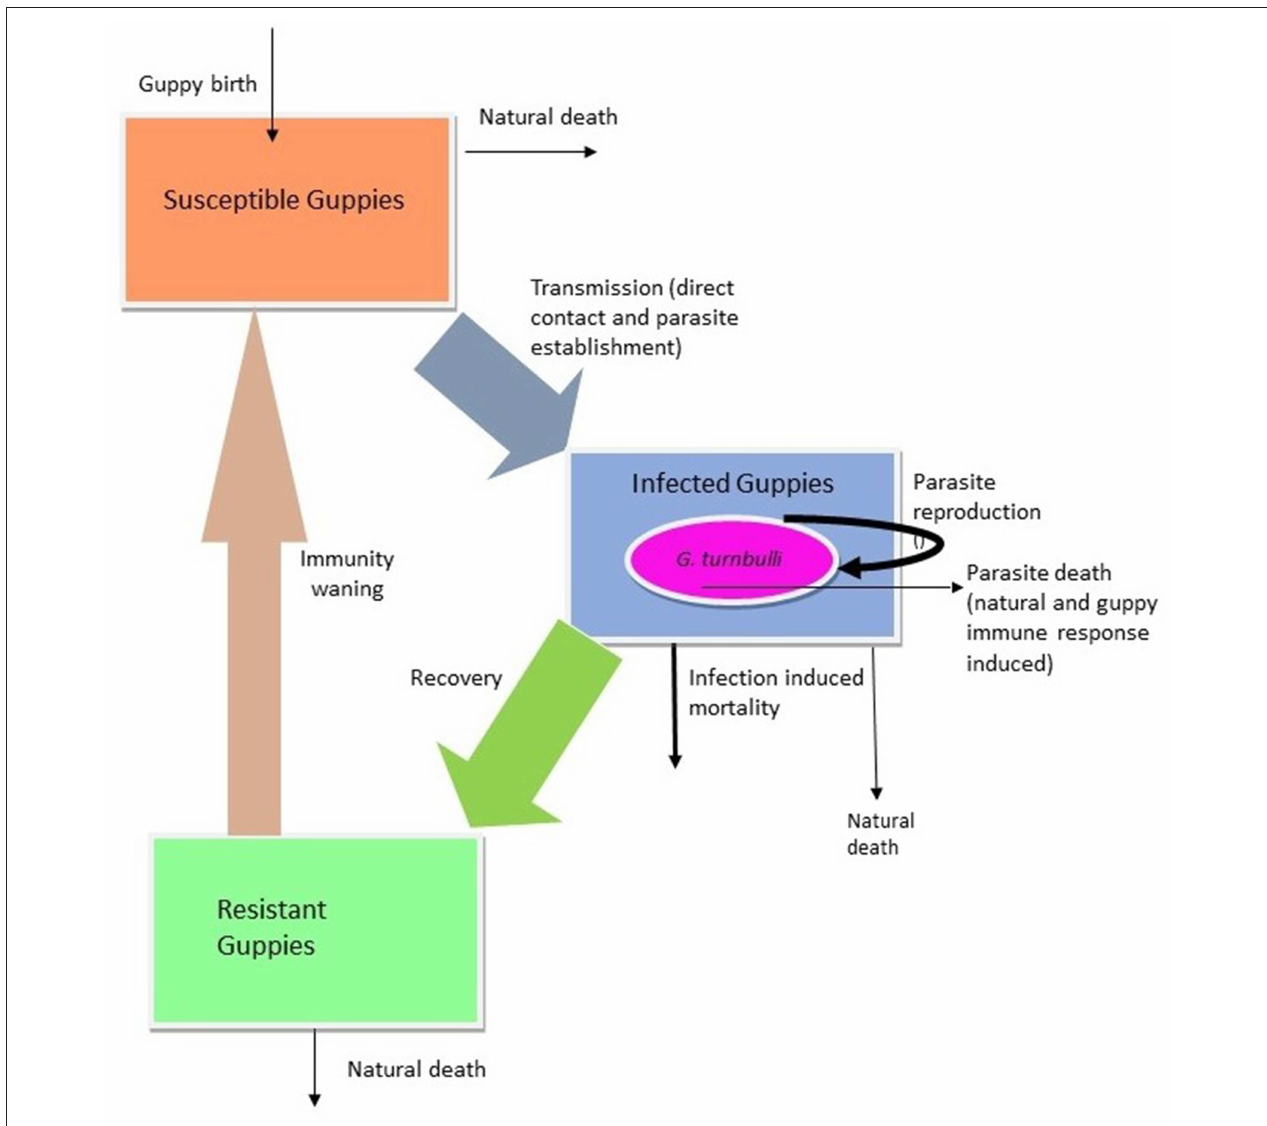
FIGURE 1 | Conceptual model of the Guppy- Gyrodactylus